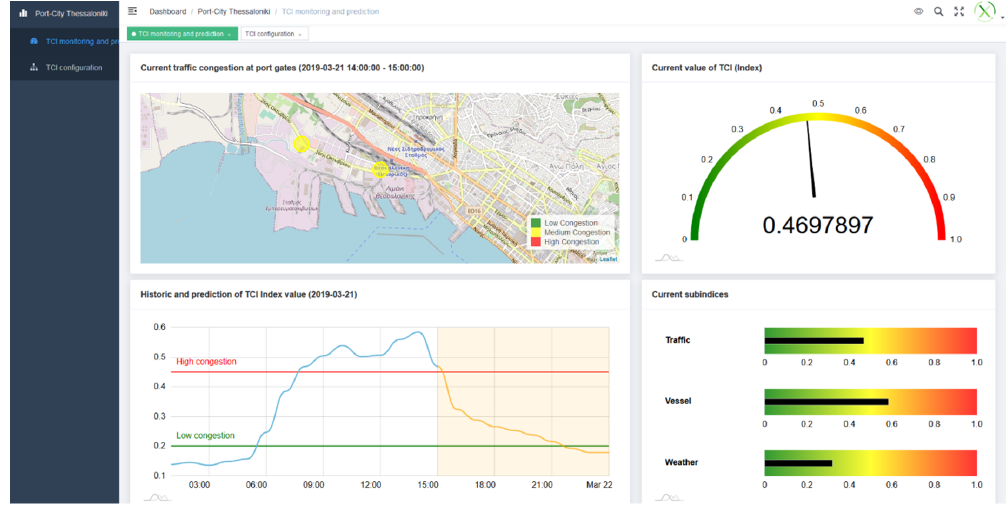
Figure A5. Visualization of the scenario 1.2 in the UI dashboard.